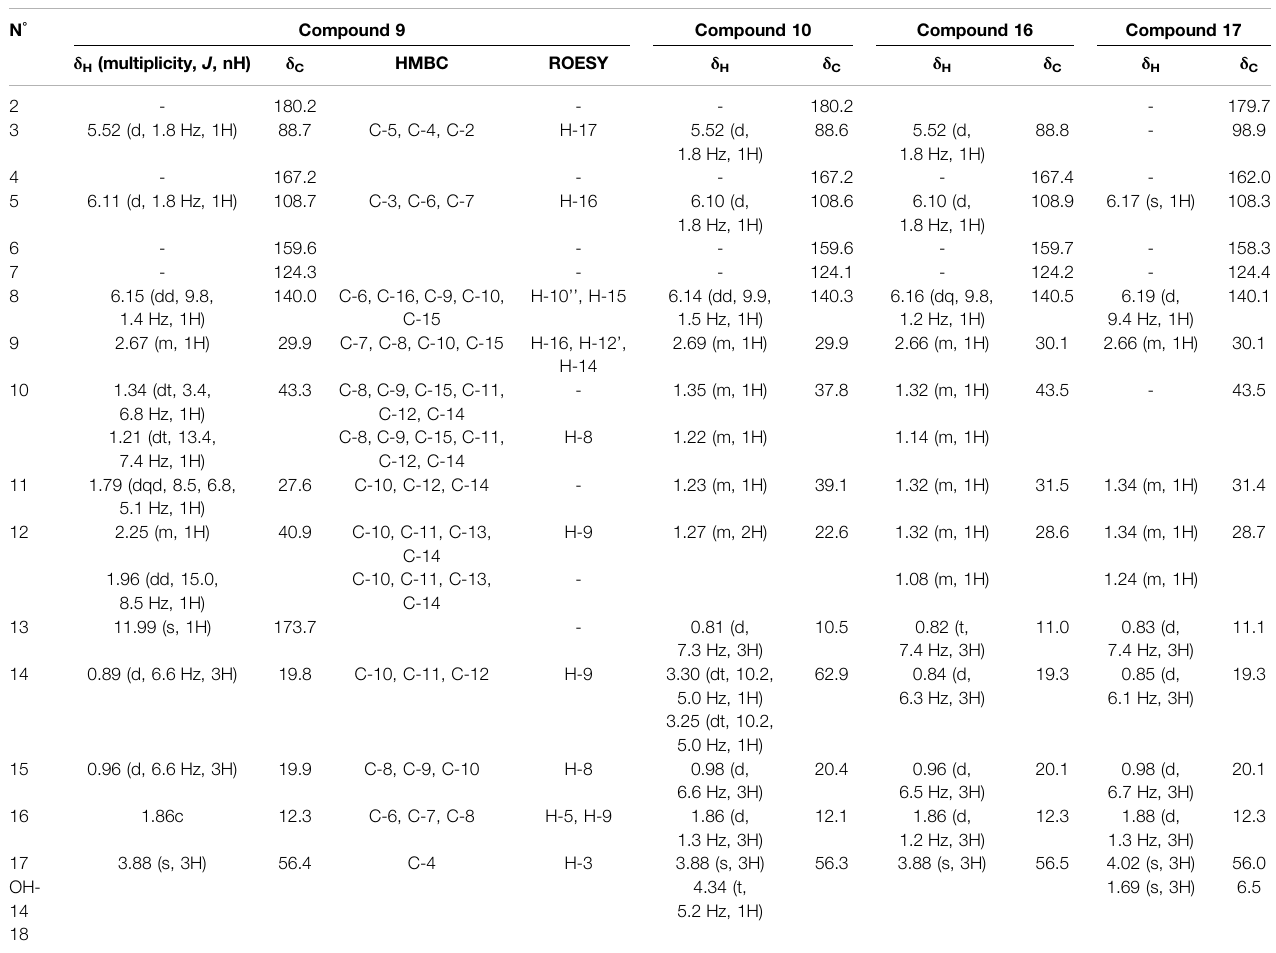
TABLE 4 | NMR chemical shifts of compound 9 , 10 , 16, and 17 in DMSO- d 6 at 600